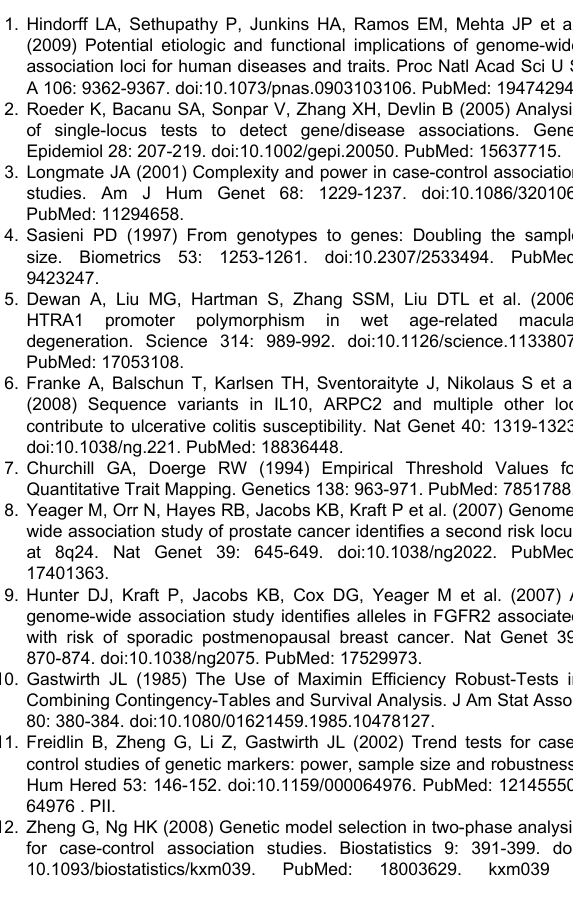
Figure S13. Empirical power of the main methods for the dual non-interacting causal variant scenario ( k =2) under Experiment I as a function of the mode of inheritance (panels), the number of SNPs in the LD block ( m ), the polychoric correlation between the genotypes of SNPs in the LD block ( ρ ) and the ADR adjustment status. The causal allele frequency is p =0.10 and the nominal type I error d rate is α =0.05. See Figure S1 for background and abbreviations.